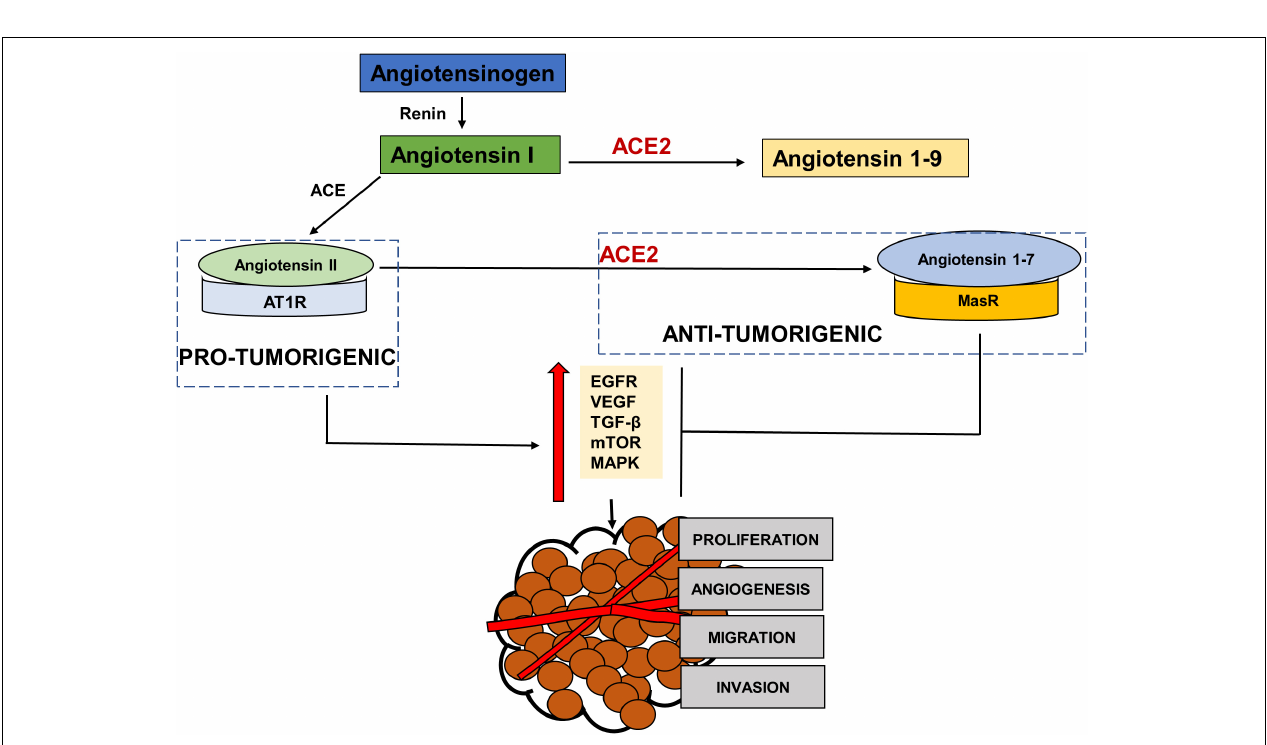
FIGURE 3 | The pro-tumorigenic and anti- tumorigenic axis of the Renin Angiotensin System (RAS). Studies have shown Angiotensin II- AT1R axis signaling to activate EGFR, VEGF, TGF β , MAPK and NFK β pathways leading to angiogenesis, migration, invasion and proliferation of tumor cells, thus acting as a pro-tumorigenic pathway. ACE2- Angiotensin 1–7- MASR acts as the anti-tumorigenic axis and blocks Ang II- AT1R induced activation of EGFR, VEGF, TGF β , MAPK pathways.